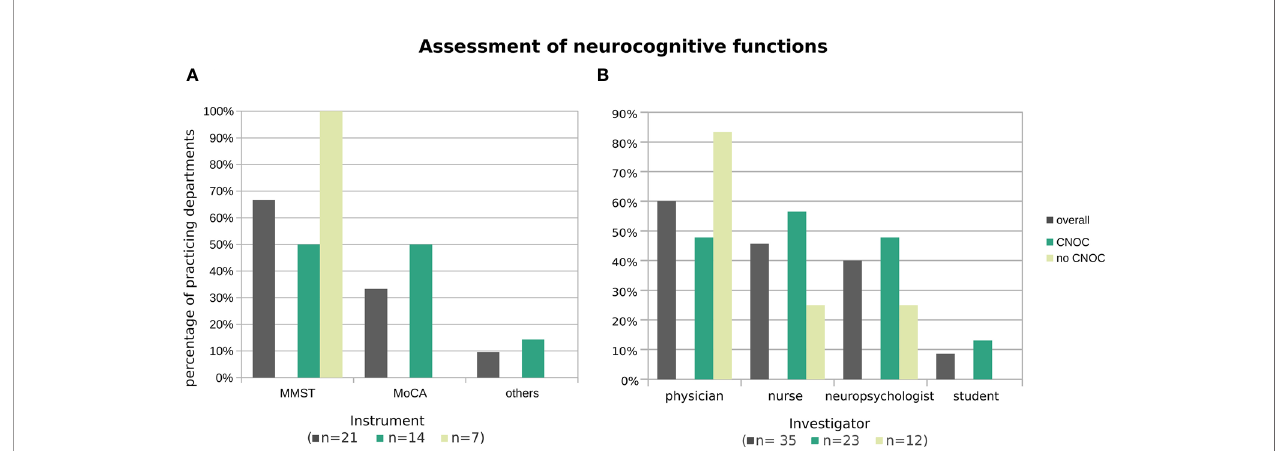
FIGURE 5 | Practiced neurocognitive assessment instruments (A) and administering professionals (B) , overall and strati fi ed by CNOC af fi liation. Histograms are based on replies from n departments practicing assessment of neurocognitive functions (with n by subgroup in brackets in the x-axis label). Multiple instruments (or multiple types of professionals) were named by 10% (21%) of departments. Other instruments (each named once) were the dementia detection screening DemTect (19) and the screening battery of the NOA-19 study (20, 21), one naming of “ others ” was not further speci fi